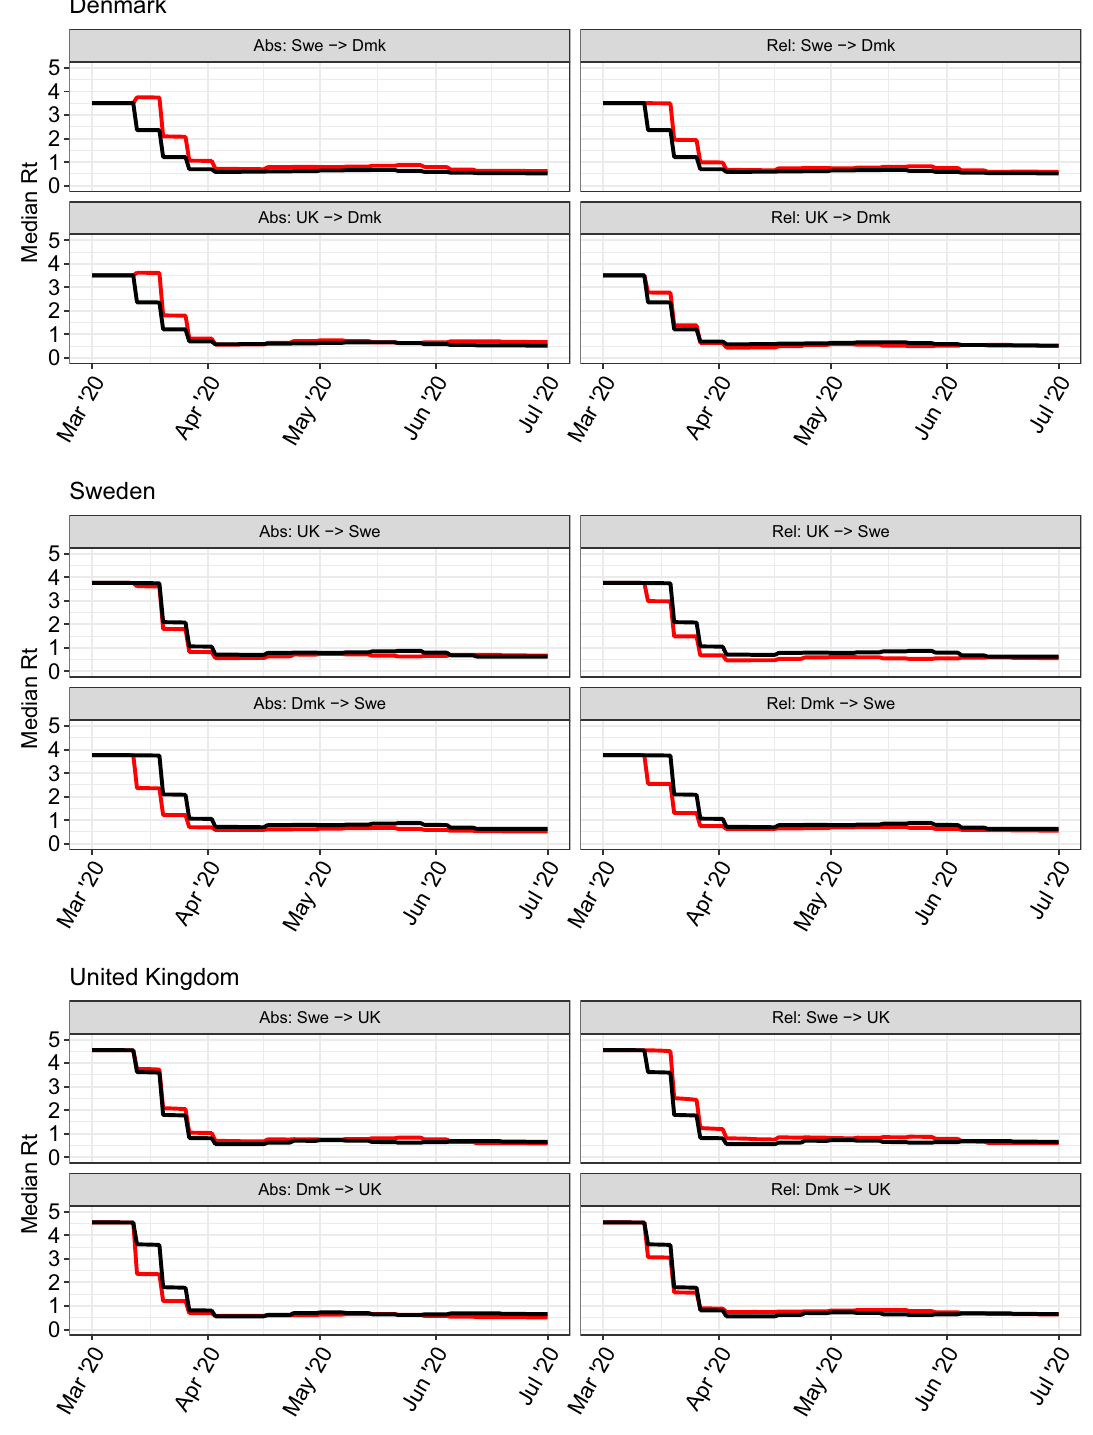
Figure 2. Median time-varying reproduction number over time ( R t ) for Denmark (top block), Sweden (middle block) and the UK (lower block). Counterfactual R t profiles are in red and original fitted R t profiles are in black. For clarity, credible intervals are not shown, (see Figure S3 for uncertainty). Left column shows results for the absolute R t transposition approach, right column for the relative R t / R 0 transposition